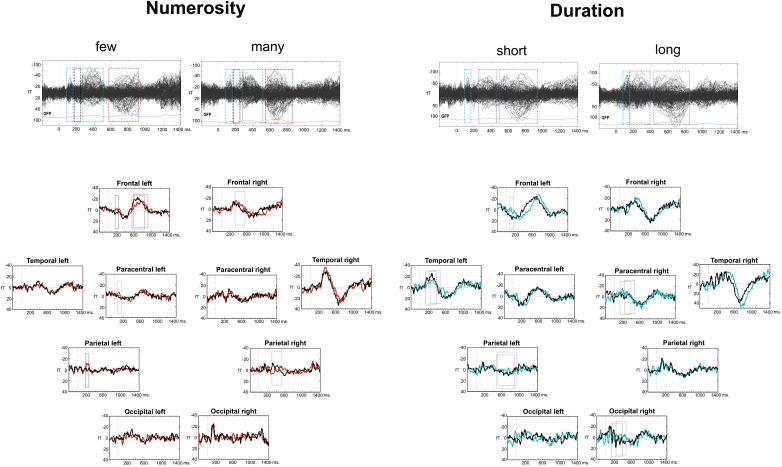
Event related fields (ERFs) for the two dimensions. The upper part of the figure contains a butterfly view off all the gradiometers for each condition and dimension. The bottom part includes the cluster averages for the two dimensions with conditions overlapped. The four or three consecutive latencies bands for analyses are displayed in squares, for numerosity and duration, respectively.